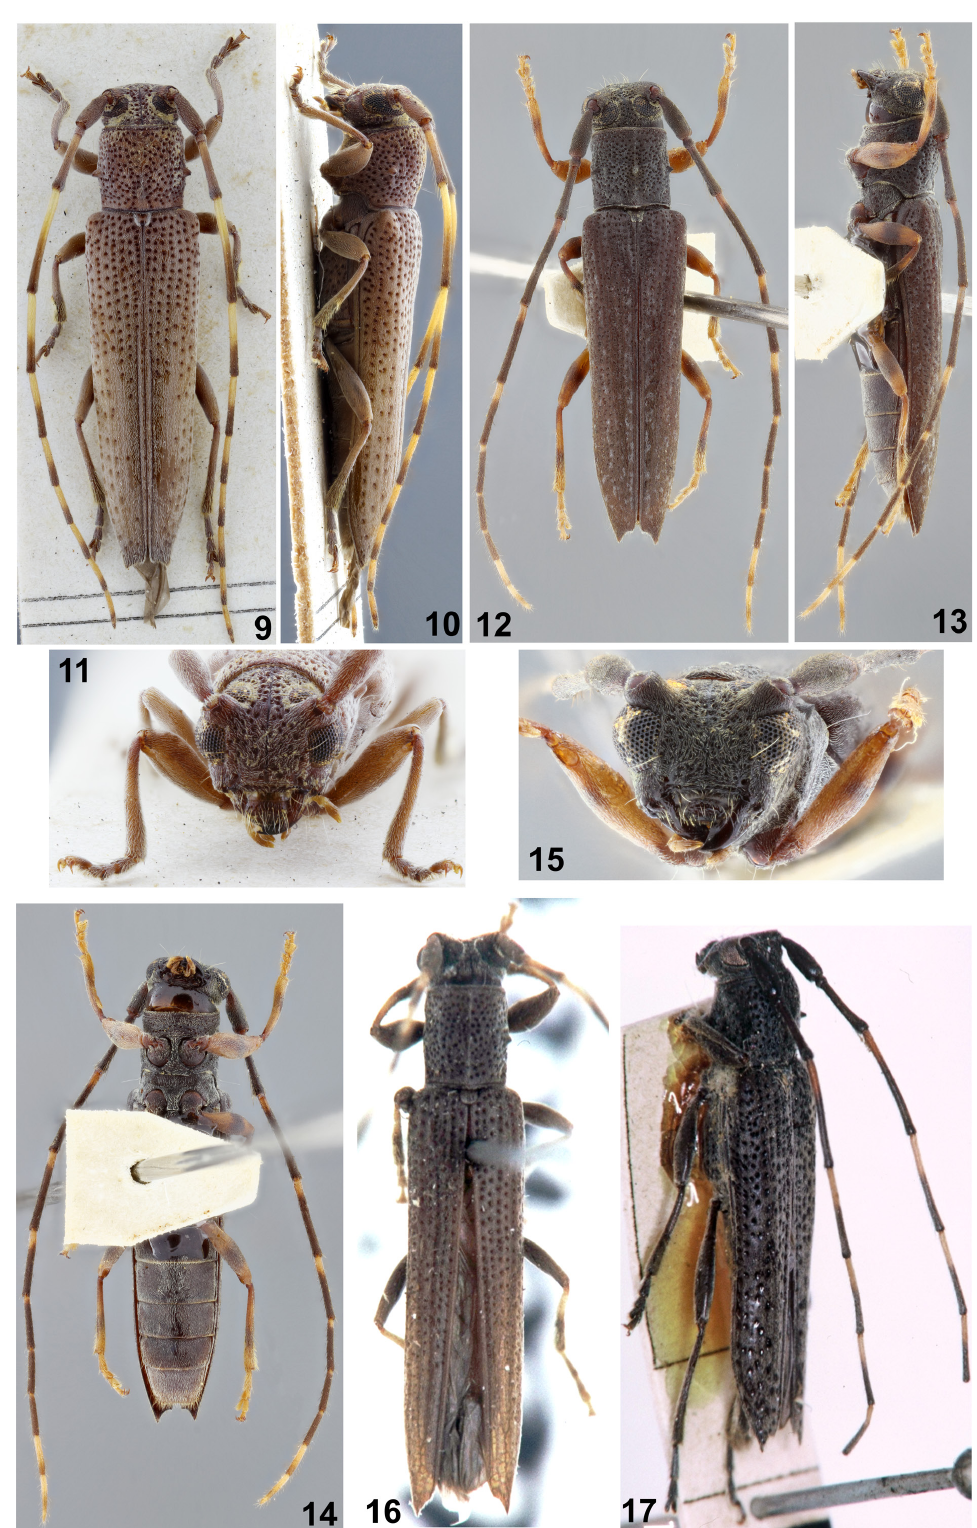
Figs 9–17. – 9–11. Nyctonympha birai sp. nov., holotype, ♀. 9 . Dorsal habitus. 10 . Lateral habitus. 11 . Head, frontal view. – 12–15 . Nyctonympha mariahelenae sp. nov., holotype, ♀. 12 . Dorsal habitus. 13 . Lateral habitus. 14 . Ventral habitus. 15 . Head, frontal view. – 16 . Nyctonympha annulata Aurivillius, 1900, syntype, dorsal habitus. – 17 . Nyctonympha carcharias Lameere, 1893, holotype, lateral